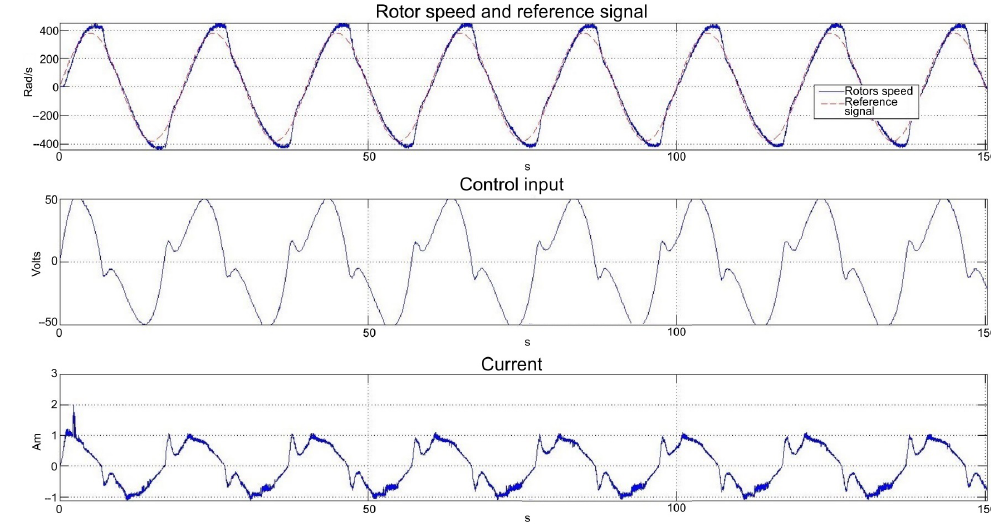
Figure 23. Responses to sinusoidal reference R ( t ) = 380sin ( 0.31416 t )